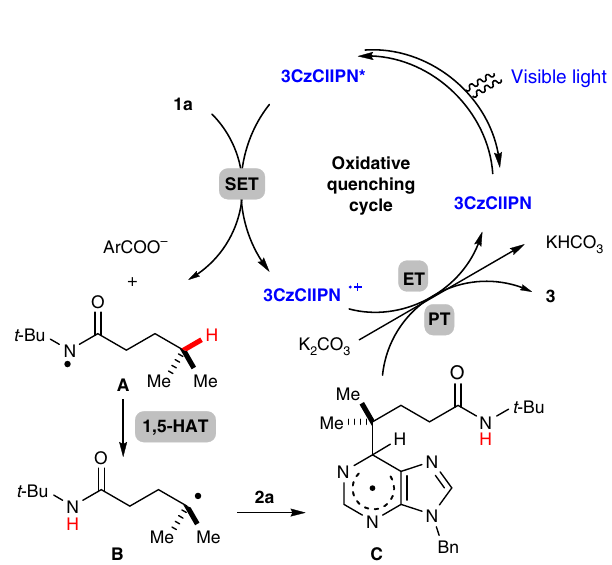
Fig. 2 Proposed mechanism. The proposed mechanism for the interrupted HLF reaction with non-prefunctionalized